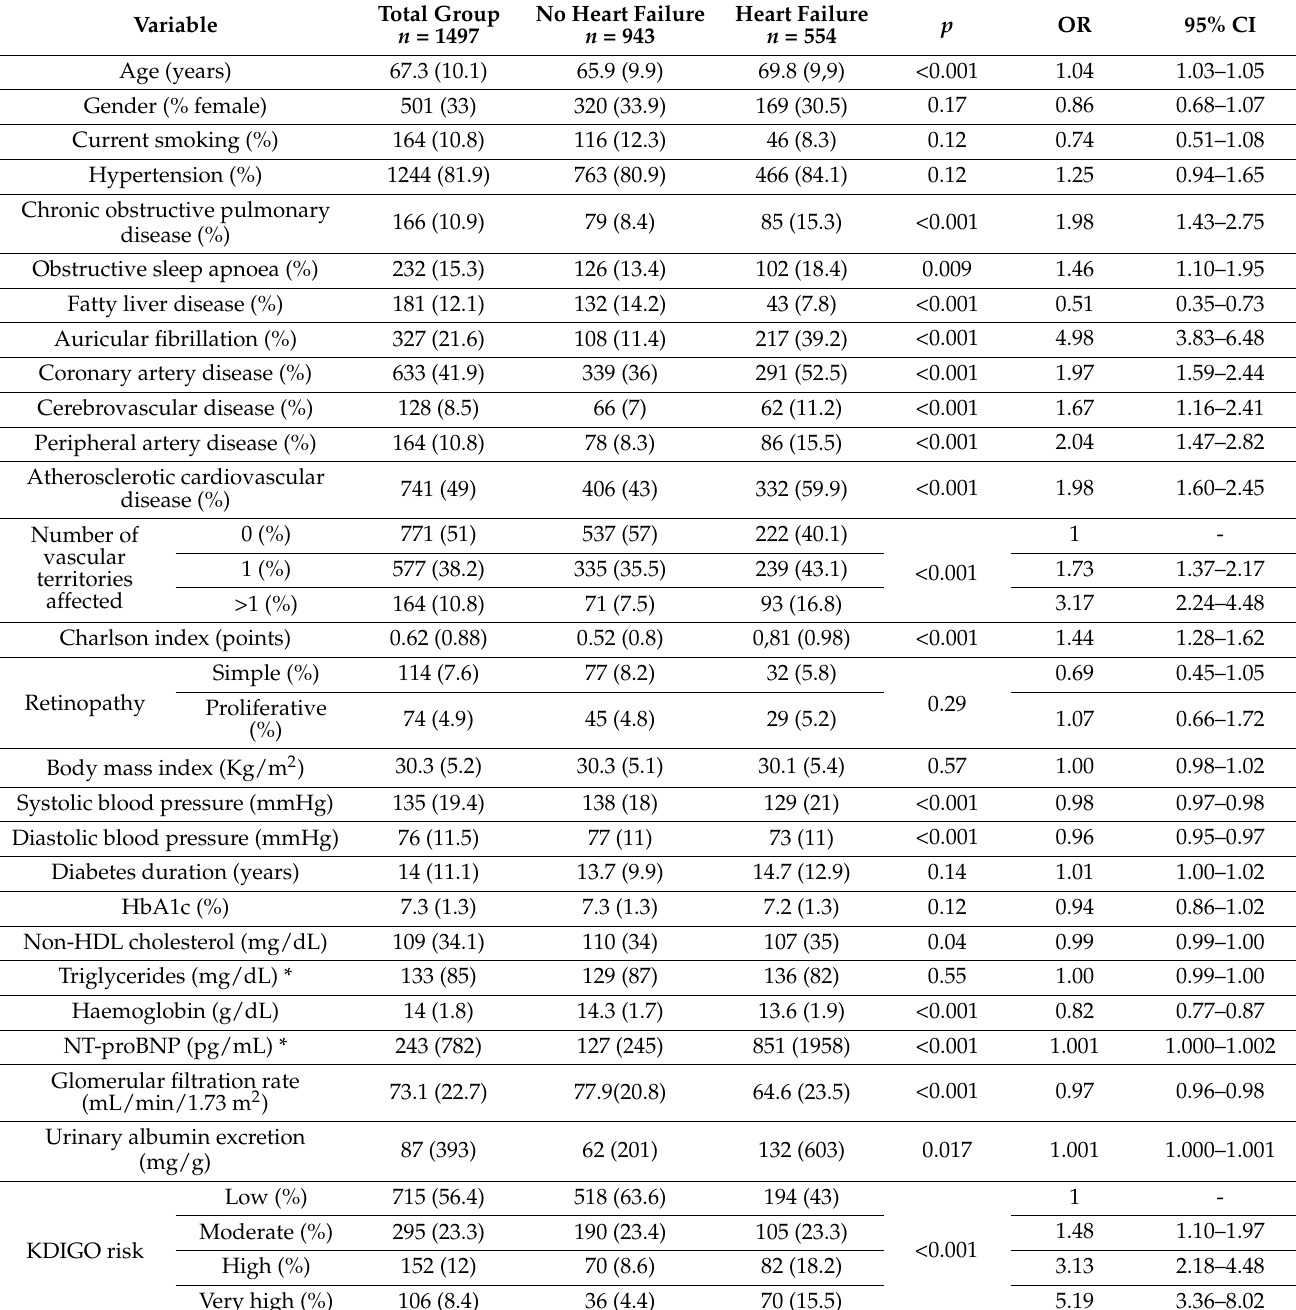
Table 1. Patients’ baseline characteristics and univariate OR for the risk of having